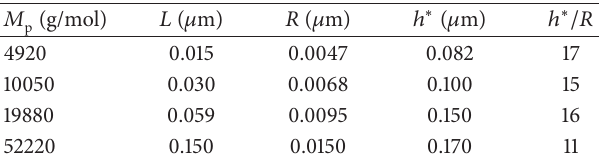
Table 3: Molecular length 𝐿 , end-to-end distance 𝑅 , length